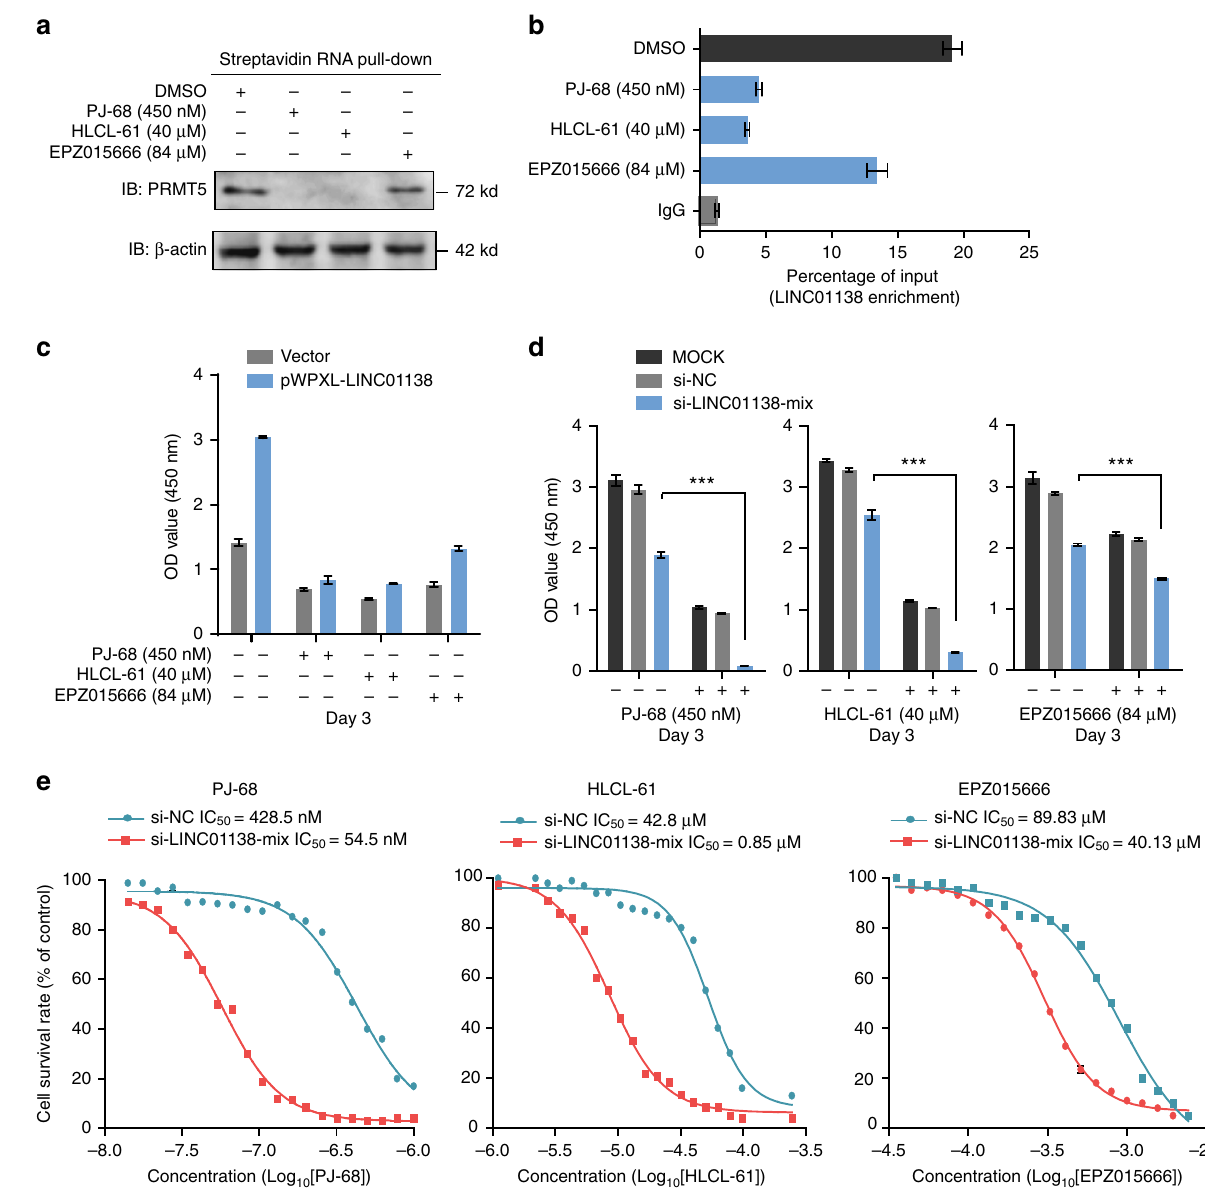
Fig. 6 The association between LINC01138 and PRMT5 is a candidate therapeutic target for HCC. a RNA pull-down assays for the speci fi c association of PRMT5 and LINC01138, in the cells exposed to PRMT5 inhibitors at the indicated concentration for 48 h. b SMMC-7721 cells were transfected with plasmids containing HA-tagged PRMT5, and RIP assays were performed using HA antibodies in the cells treated with PRMT5 inhibitors at the indicated concentration for 48 h. c CCK-8 assays for pWPXL-LINC01138 or vector cells, exposed to PRMT5 inhibitors at the indicated concentration for 3 days. d CCK-8 assays in cells transfected with si-NC or si-LINC01138 mixture, exposed to PRMT5 inhibitors at the indicated concentration for 3 days. e IC 50 were analysed in cells transfected with si-NC or si-LINC01138 mixture, exposed to PRMT5 inhibitors for 3 days. Values are expressed as the mean ± SEM, n = 3 b – e . ** P < 0.01 and *** P <